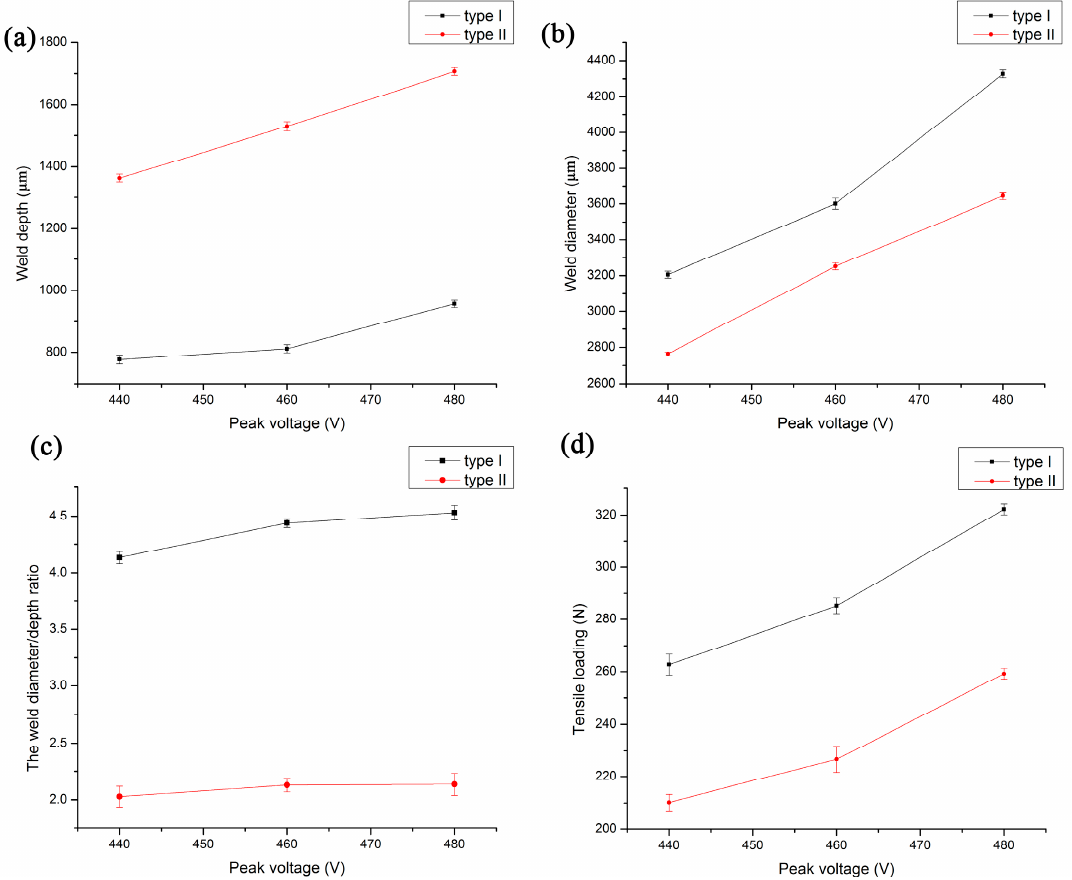
Figure 8. The effect of peak voltage on the welding conditions of type I and type II when defocusing distance is 8 mm. ( a ) Weld depth; ( b ) weld diameter; ( c ) the weld diameter:depth ratio; ( d ) tensile loading.